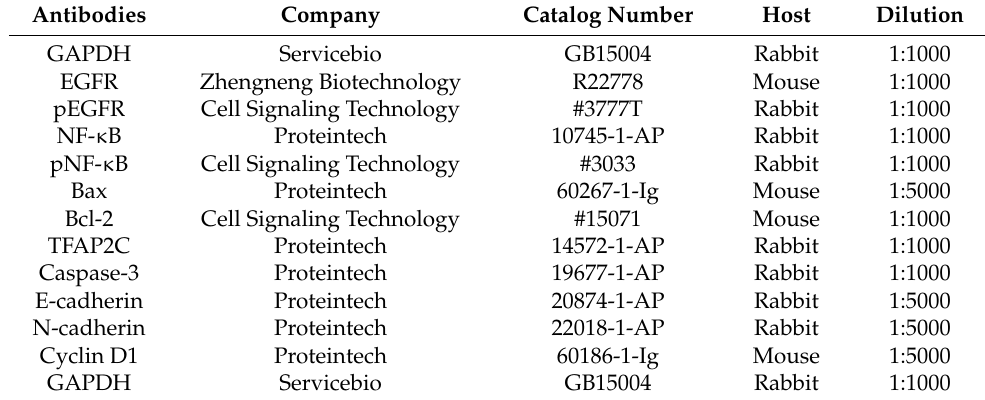
Table 1. Antibodies used in WB.